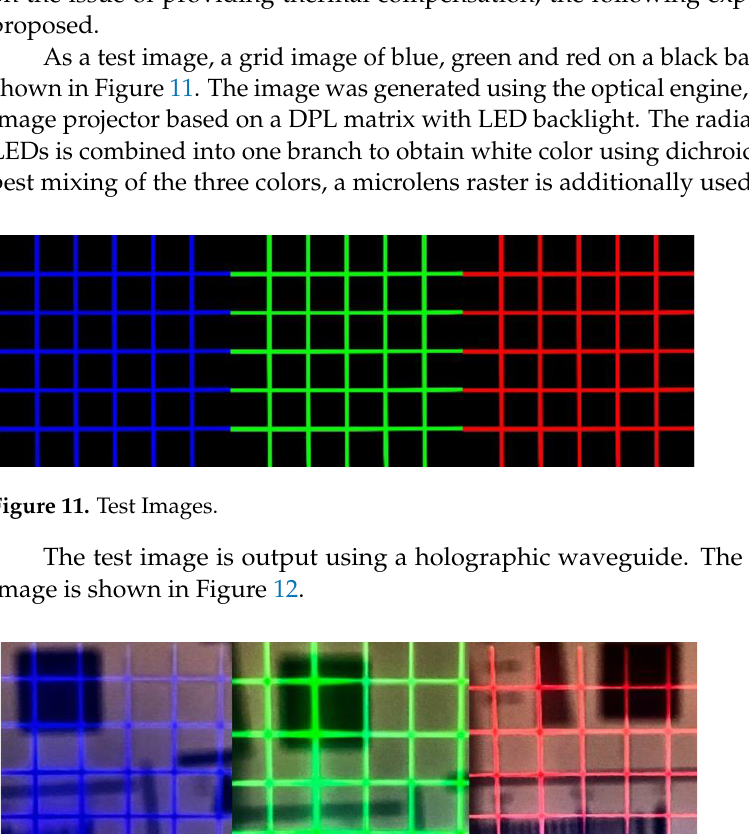
Figure 13. The scheme for determining the angular displacement of the output image. 1 – 3 — colli- mator (2 — measuring grid); 4 — waveguide; 5 – 18 — optical engine (13, 16, 18 — LEDs; 8, 12, 15, 17 — lenses; 10, 11, 14 – mirrors; 9 — microlenses; 6 — prism; 7 — display; 19 — filter only for green LED).